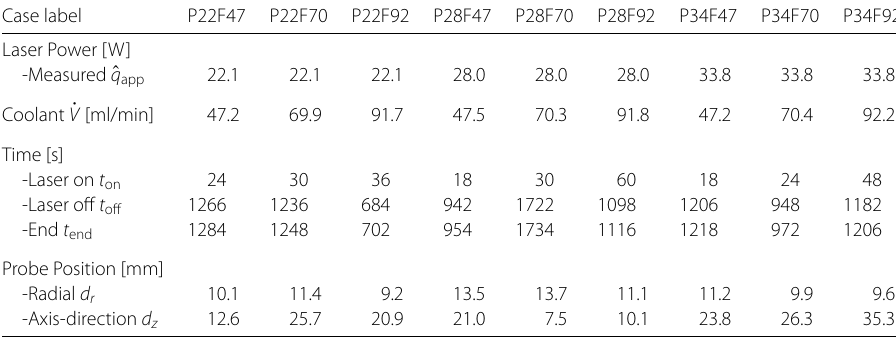
Table 1 Experimental setup for nine test cases (from [4]) Case label